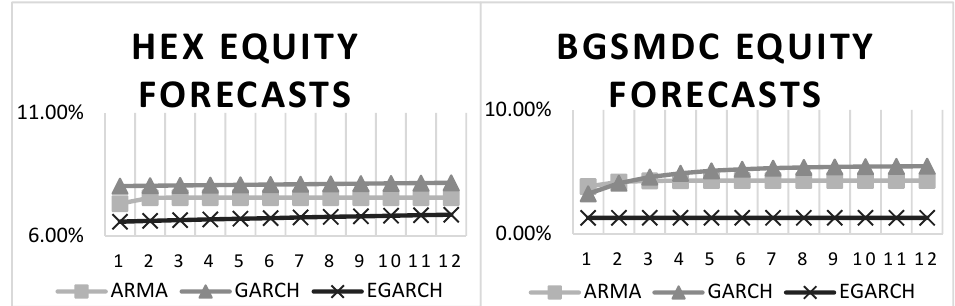
Figure 16. Equities model forecasts (12 months). Source: authors.